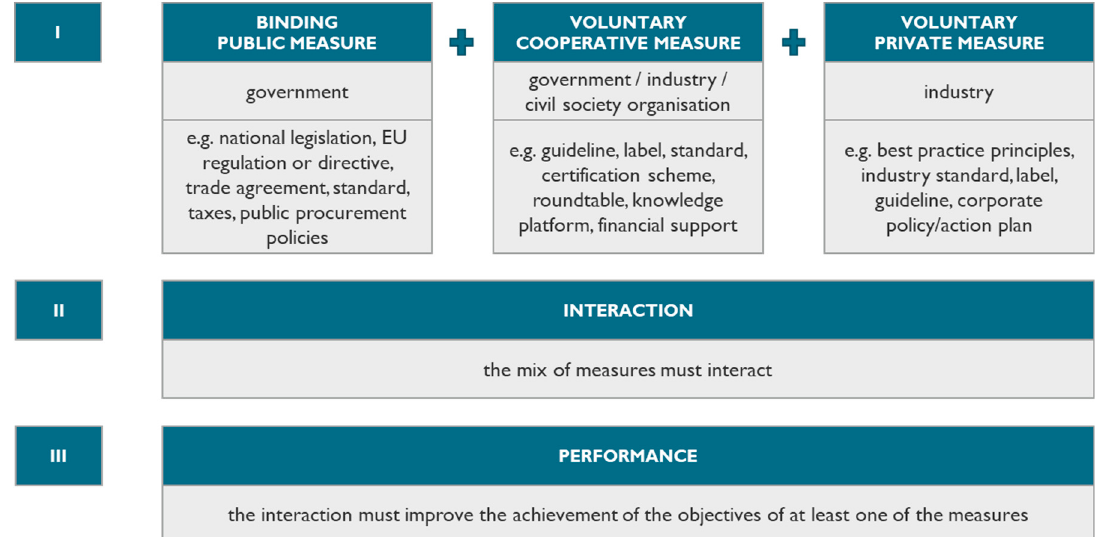
Figure 1. Components and conditions of a Smart Mix.